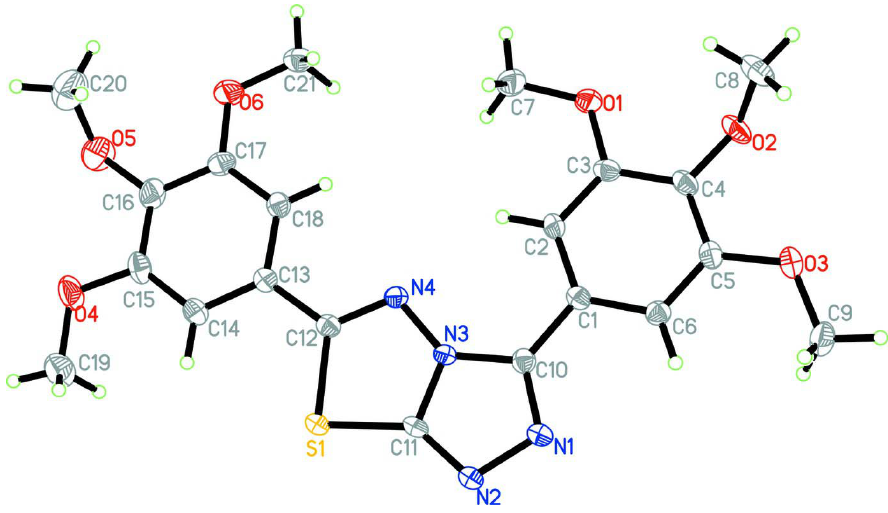
The molecular structure of the title molecule, with the atom-numbering scheme. Displacement ellipsoids are drawn at the 50% probability level.